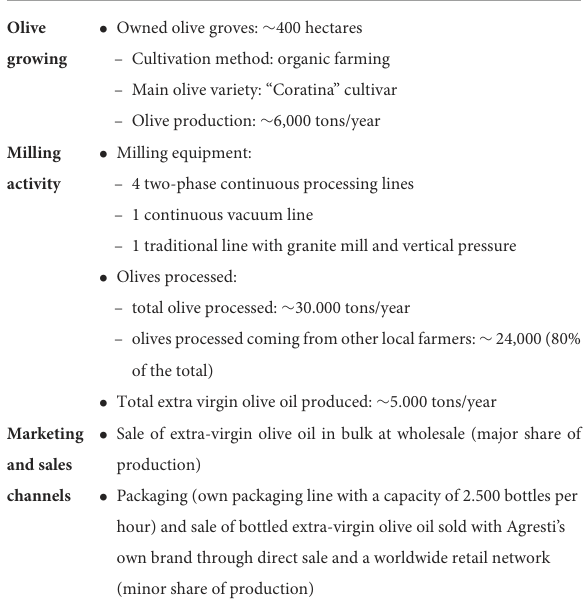
TABLE 1 The core structure of the case firm in numbers and data.